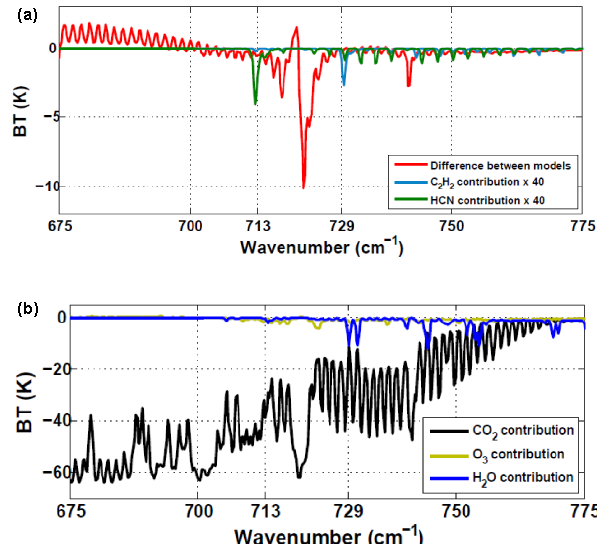
Fig. 1. (a) The red line shows the difference between the forward models with and without CO 2 line mixing considered. To make them visible, contributions of HCN (green line) and C 2 H 2 (blue line) are shown for background concentrations multiplied by 40. (b) Contribution of CO 2 (black line), O 3 (ochre line) and H 2 O (deep blue line) to a simulated spectrum for background concentrations in a standard atmosphere. Calculations have been made for the US Standard Atmosphere (US Government Printing Office, 1976) with CO 2 concentrations scaled to